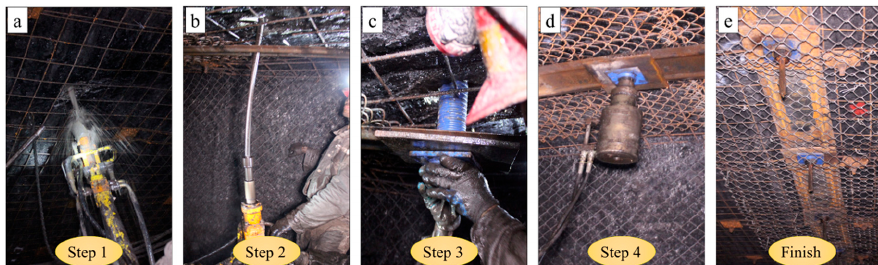
Figure 17. Construction process of the CRLDA cable: ( a ) Drilling cable holes; ( b ) Installing stranded steel rope and anchoring resin; ( c ) Installing cable accessories; ( d ) Imposing pre-tightening force; ( e ) Installing complete.